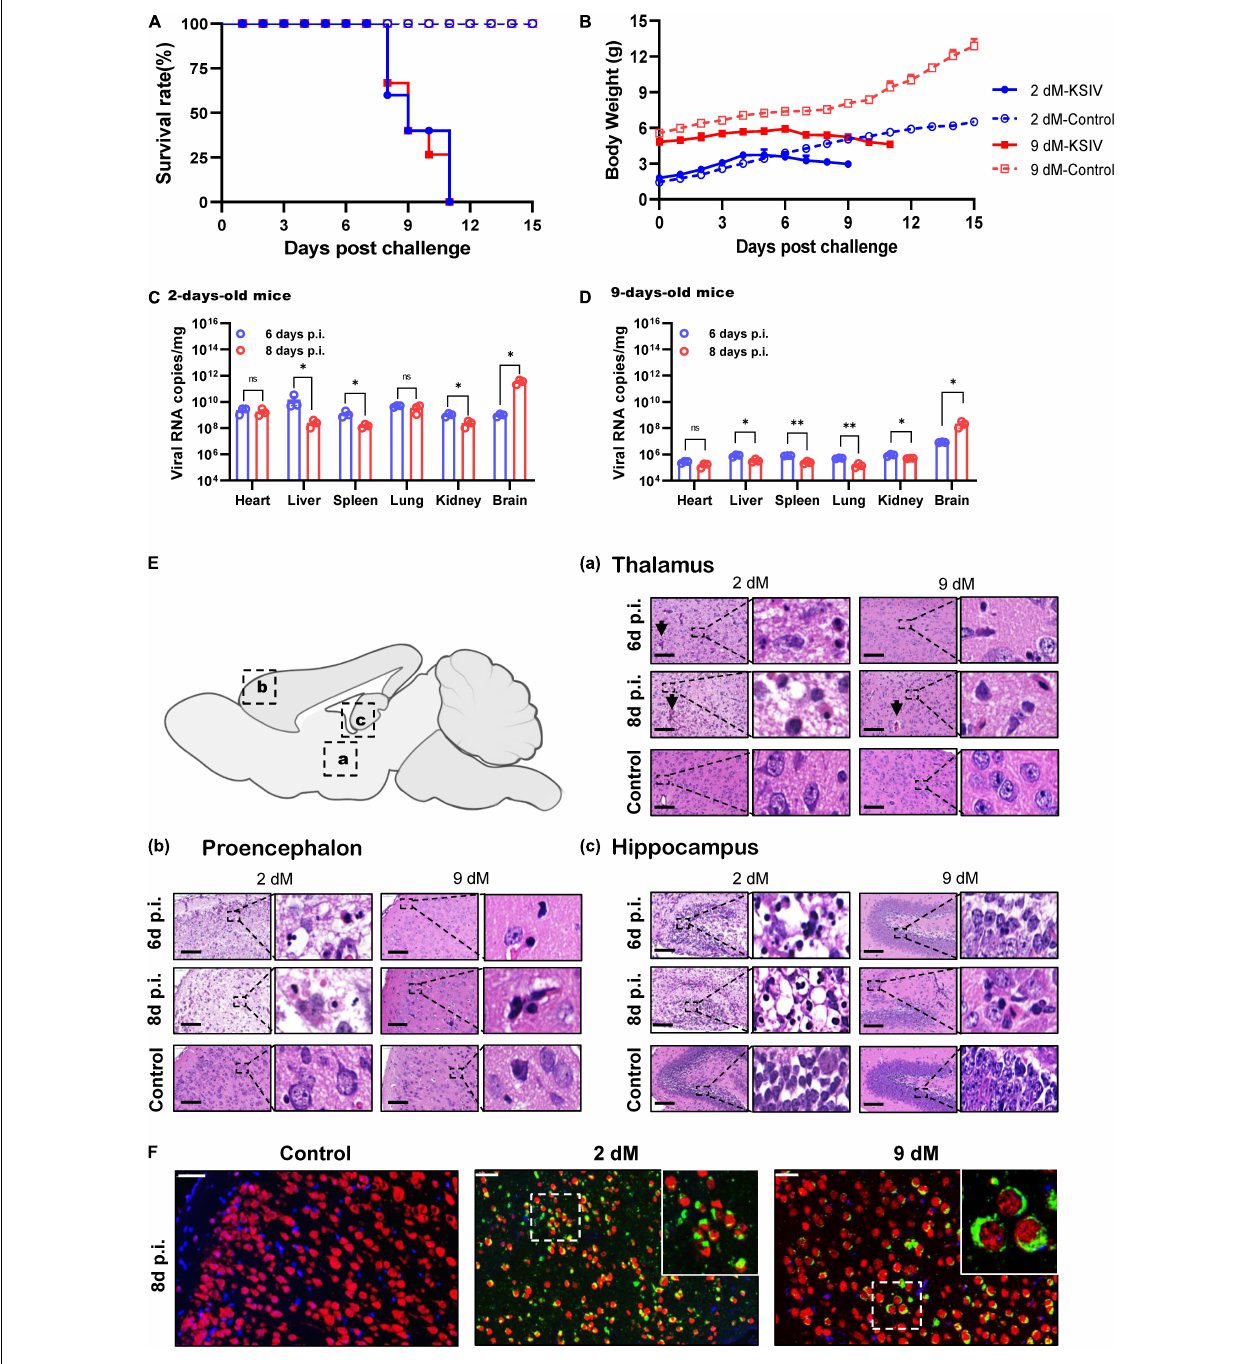
FIGURE 3 | The pathogenicity of KSIV infection in 2- and 9-day-old suckling C57BL/6 mice. The 2- and 9-day-old suckling C57BL/6 mice (2- and 9-dM) were inoculated with KSIV intracranially (1 × 10 4 PFU) and intraperitoneally (2 × 10 4 PFU) and monitored for clinical symptoms and mortality over 15 days. (A) Survival analysis of mice infected with KSIV. (B) Bodyweight changes of mice infected with KSIV. Mice were inoculated with KSIV and different tissues were collected at 6- and 8-days post inoculation ( n = 3/group) to enable comparisons of virus loads between the 2-day-old (C) and the 9-day-old (D) infected mice groups. For each time point, the measured values are the average of three mice. Error bars represent standard deviations. Data shown are pooled from three independent experiments. n.s. indicates no significant difference, ∗ p < 0.05, ∗∗ p < 0.01. (E) H&E staining of brains from 2- to 9-day-old KSIV-infected and uninfected suckling mice. At 6- and 8-days post inoculation, mice were euthanized, and brains were H&E stained. Representative images of the brain from (a) thalamus, (b) prosencephalon, and (c) hippocampus. Scale bars represent 100 µ m. The enlarged images of interest show details demonstrating inflammation and neuronal necrosis. (F) Double immunofluorescence staining was performed on mouse brain sections from 2- to 9-day-old mice 8 days after KSIV infection, and on uninfected mice. The mature neurons were marked with red fluorescence (Alexa Fluor 555), KSIV antigens were stained with green fluorescence (Alexa Fluor 488), and the nuclei were stained with Hoechst